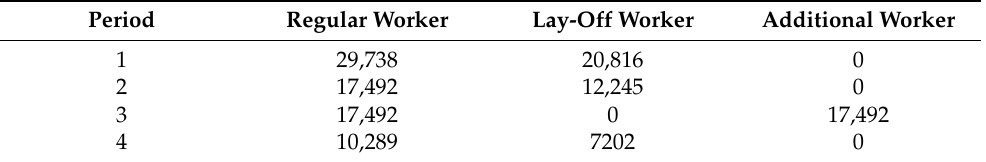
Table 13. Number of workers.